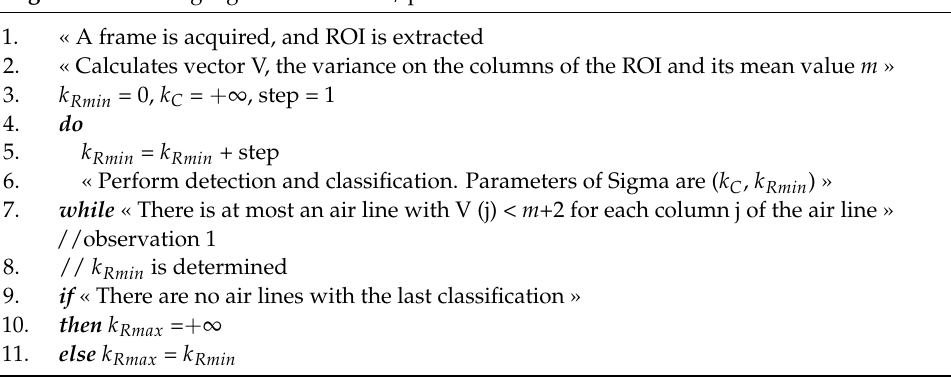
Algorithm 3 Tuning algorithm for the k r